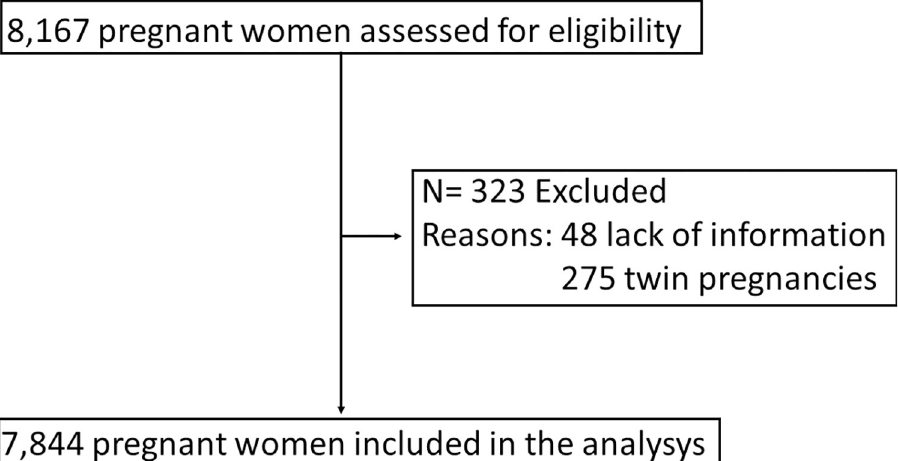
Fig 3. Inclusion and exclusion flowchart. Eligible pregnant women, excluded and included in the